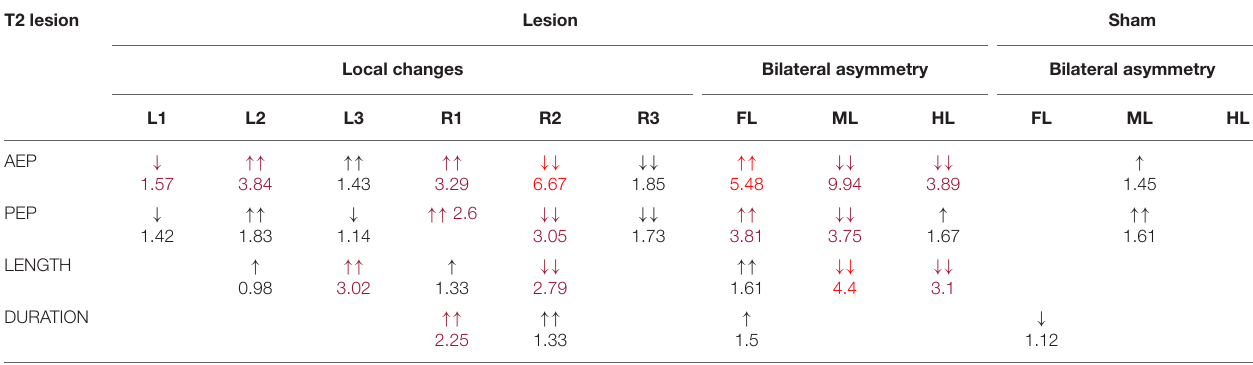
TABLE 1 | Summary of the changes in step parameters induced by a lesion of the pro-to-mesothorax connective. T2 lesion Lesion Sham Local changes Bilateral asymmetry Bilateral asymmetry